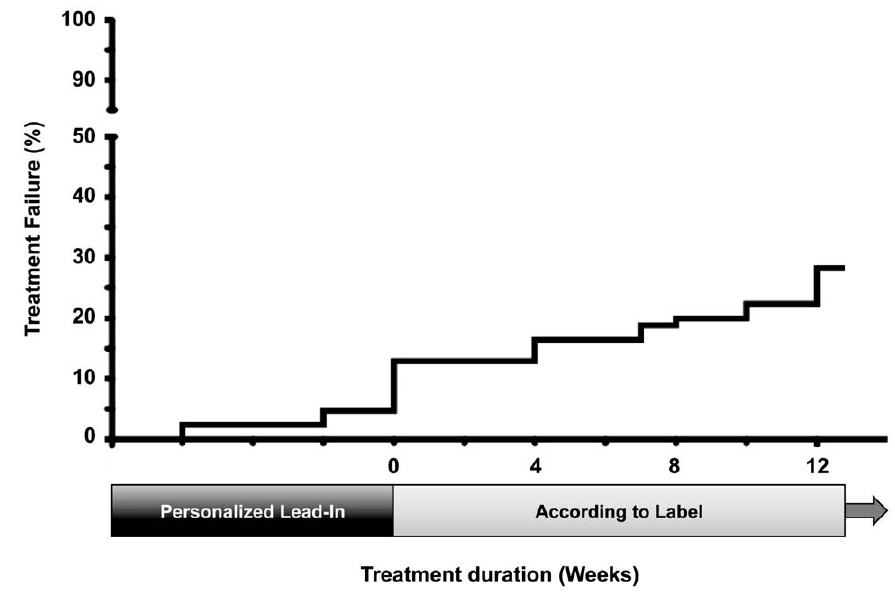
Figure 2. Treatment failures during the observed time period.